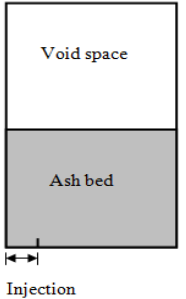
Figure 34. Channel geometry in Perkins and Sahajwalla [61].